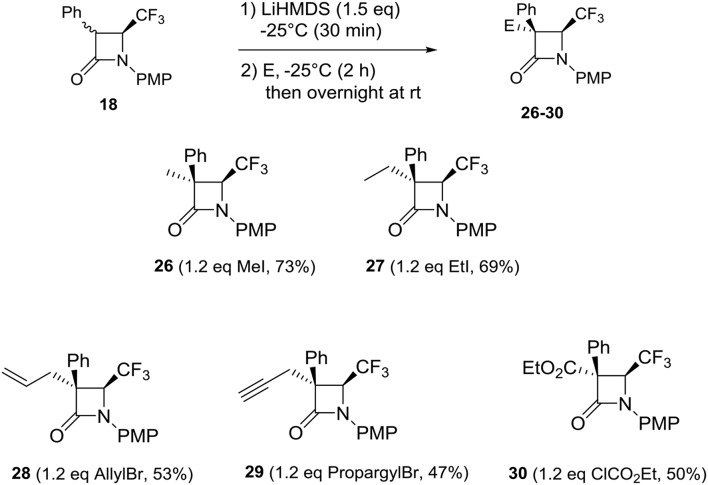
Reactions of 3-Ph 4-CF3 β-lactams 18 with electrophiles.